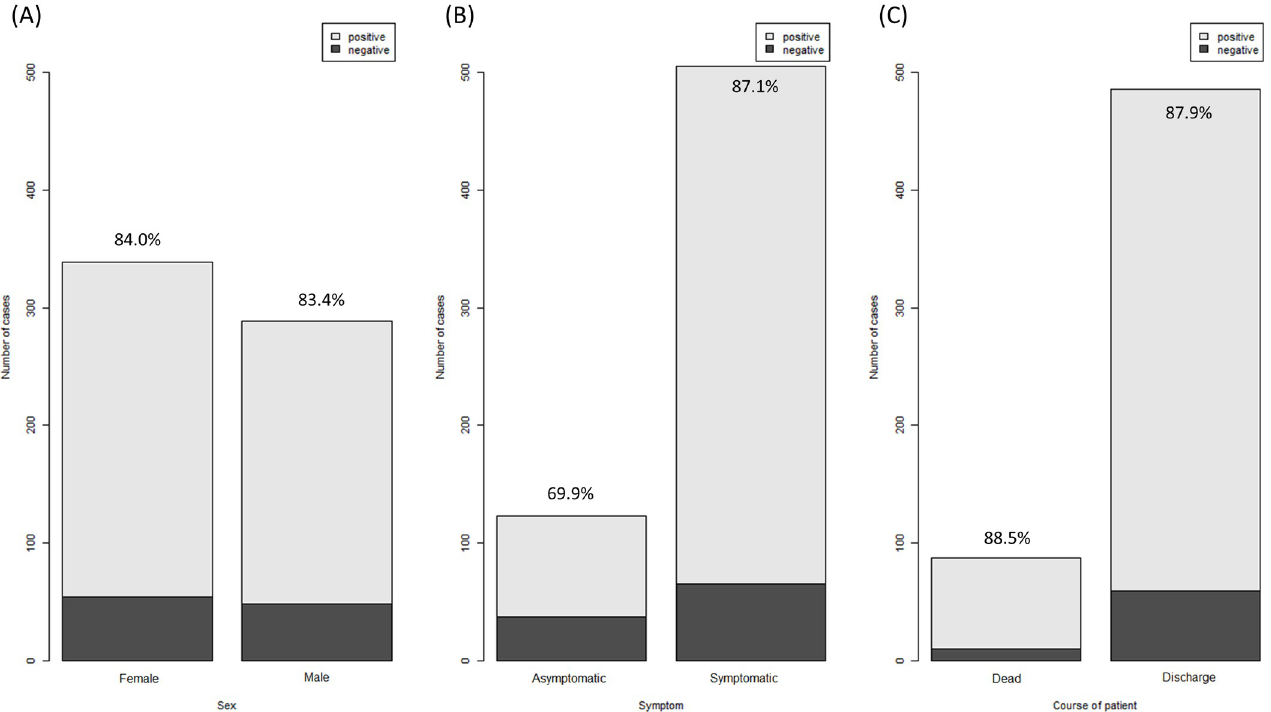
Fig 3. Anti-SARS-CoV-2 antibody positivity rate according to sex (A), symptoms (B), and disease course (C). Numbers above bars are positivity rates.